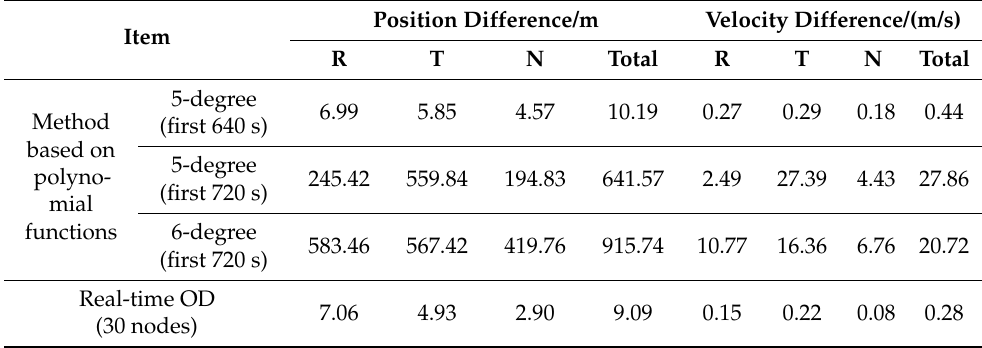
Table 2. Descent trajectory difference between the methods based on polynomial functions and B-spline function with 60